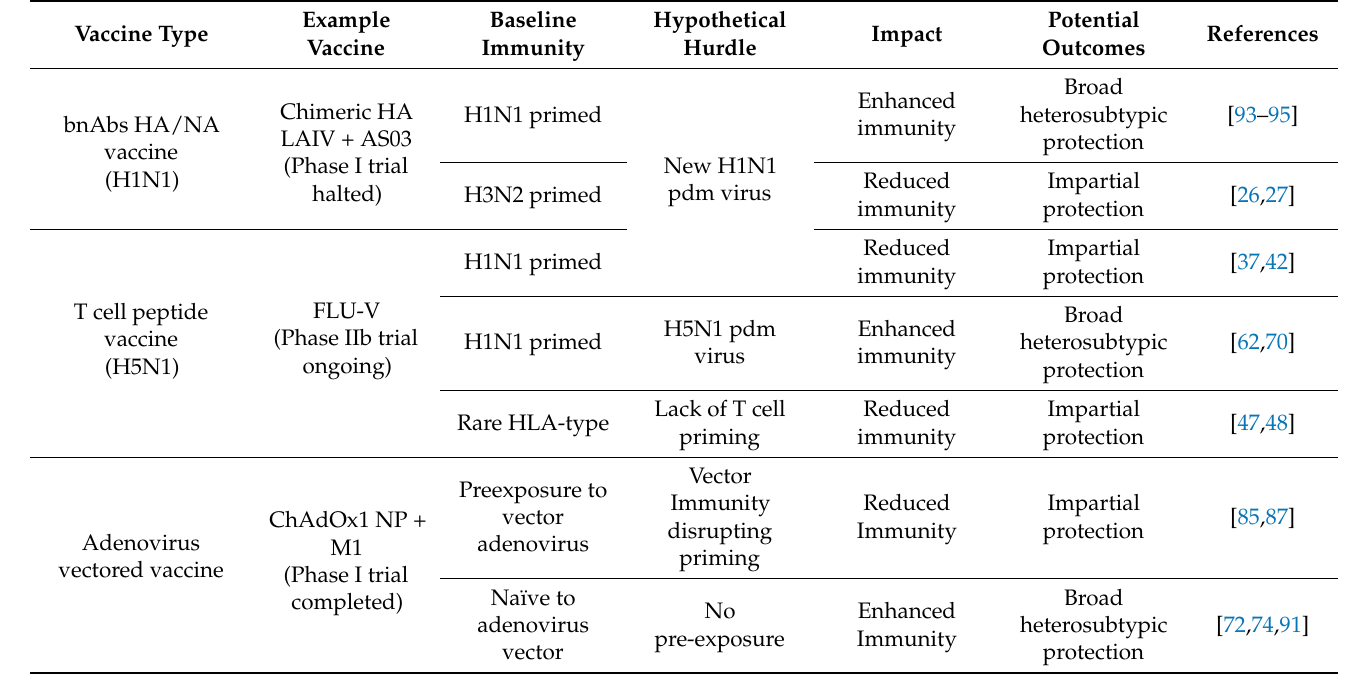
Table 1. Summary of potential outcomes and hurdles for next generation influenza